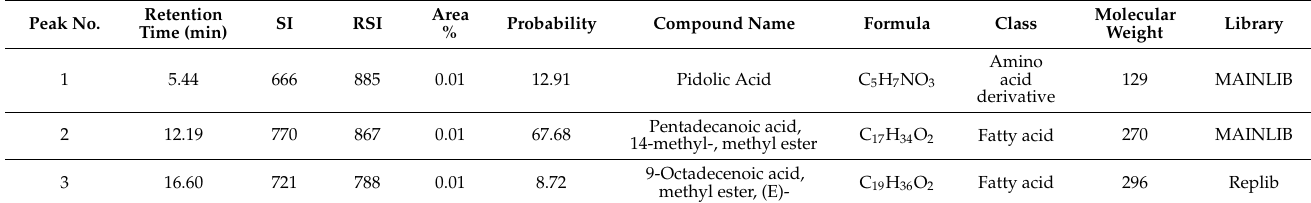
Table 3. Percent inhibition of acetylcholinesterase by MEC and NBFC .